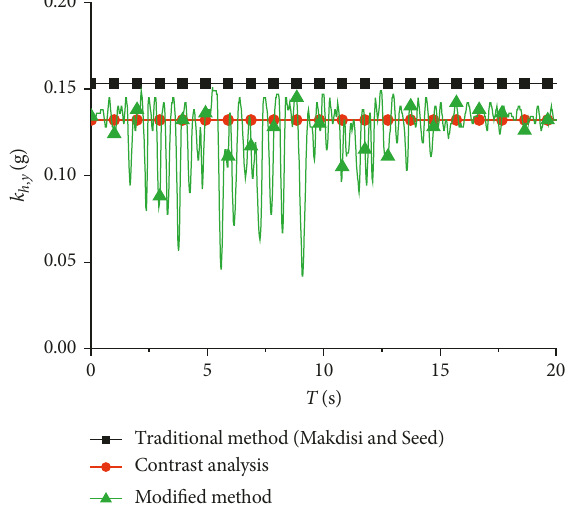
Figure 5: Time history horizontal critical acceleration.